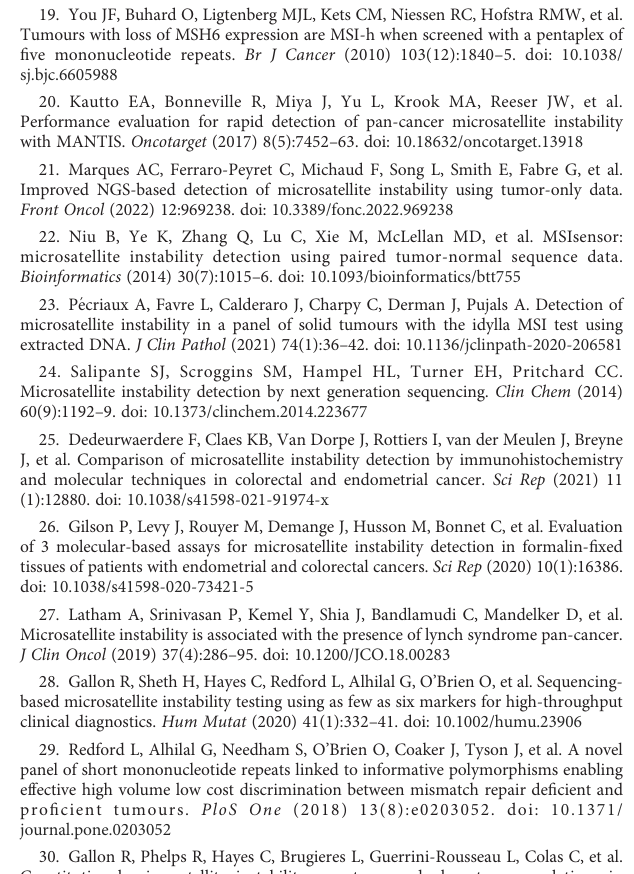
SUPPLEMENTARY TABLE 1 An overview of the immunohistochemistry, MSI analyses and relevant clinical